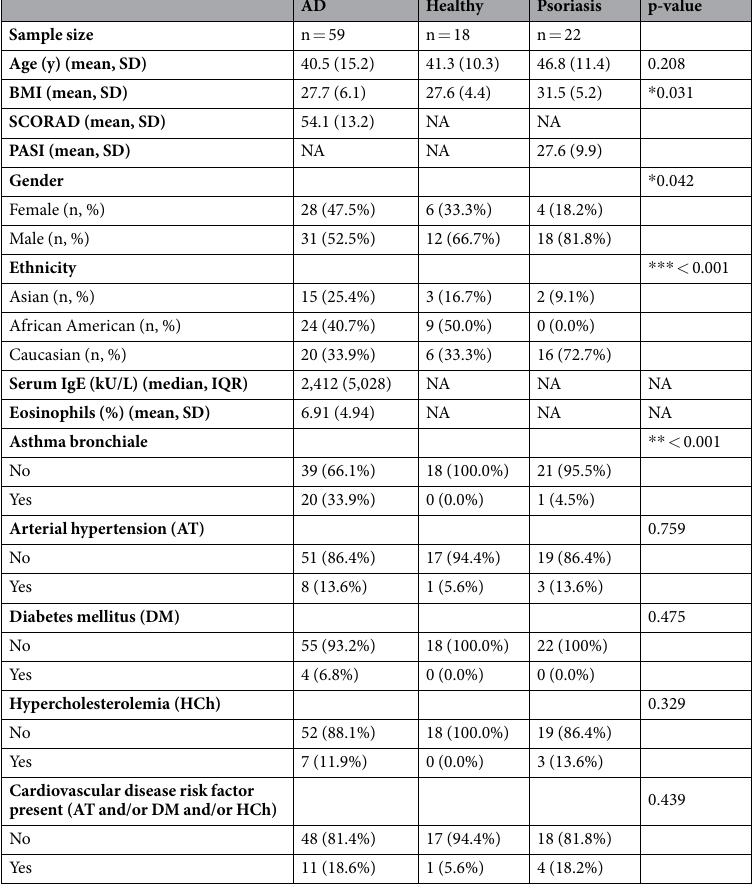
Table 1. Summary of demographics and disease severity of study subjects. One-way ANOVA was used for comparisons of means, and Fisher’s exact test was used for comparisons of proportions; * p < 0.05, ** p <